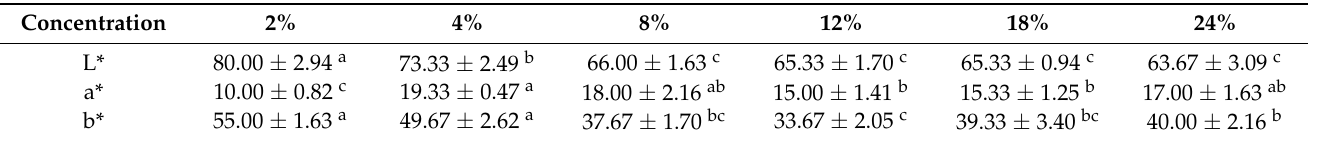
Table 1. L*, a*, and b* parameters of DCF dispersion with different concentrations.